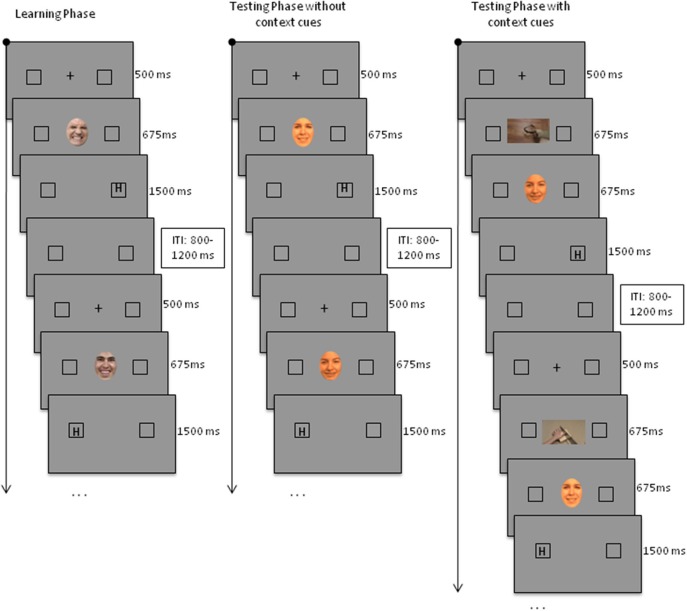
Typical trial configuration for the learning and testing phases of the incidental learning task.